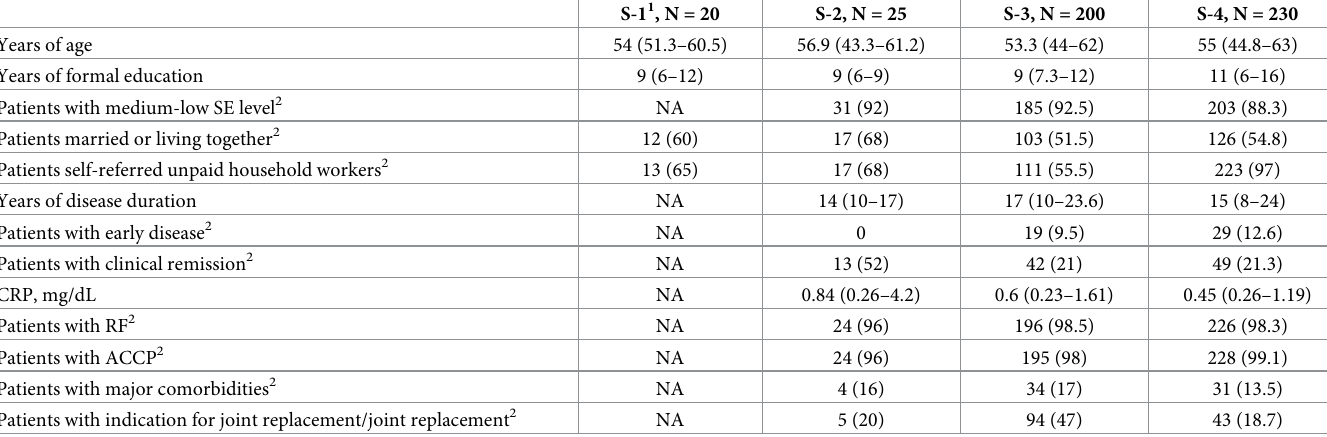
Table 2. Description of the samples´ characteristics.